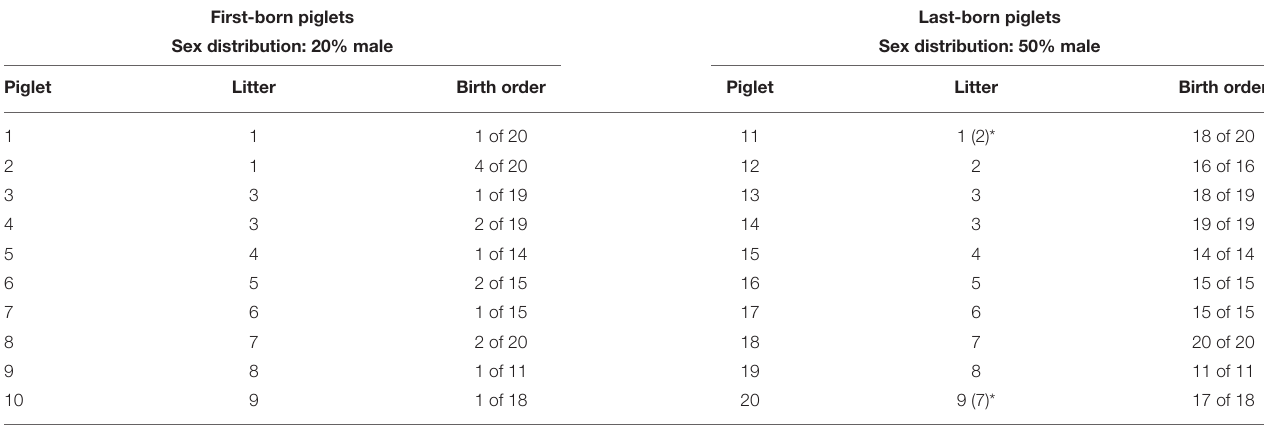
TABLE 1 | Pigs selected for the judgement bias test. First-born piglets Last-born piglets Sex distribution: 20% male Sex distribution: 50% male Piglet Litter Birth order